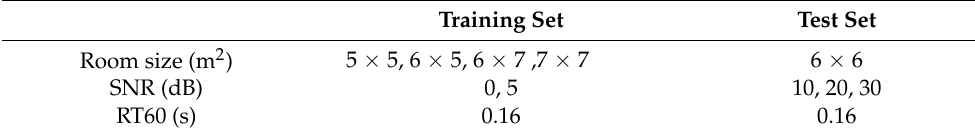
Table 2. A single acoustic environment configuration.